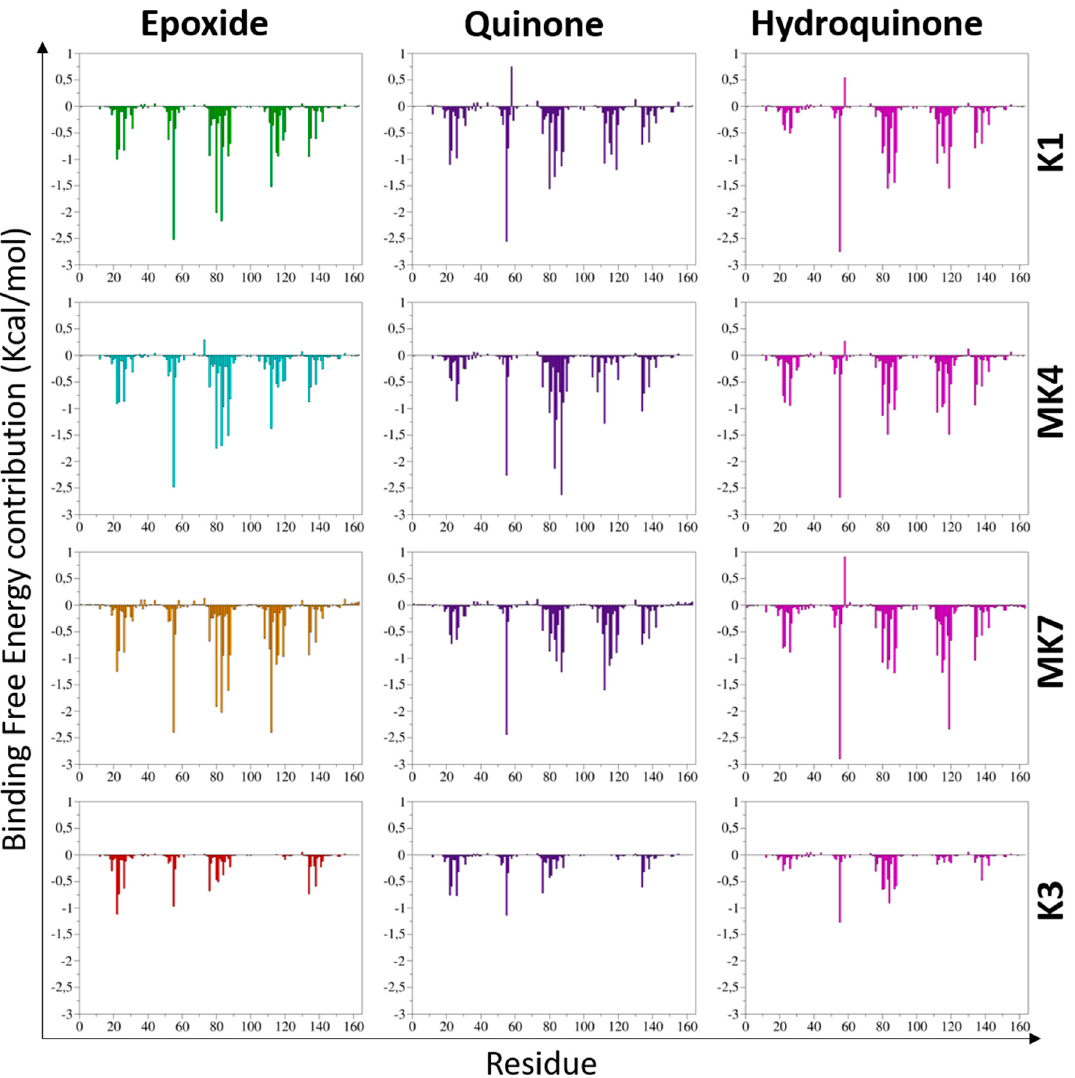
Figure 2. Contribution of vitamin K epoxide reductase (VKORC1) amino acids to the binding of vitamins K1, MK4, MK7, and K3 in their epoxide, quinone, and hydroquinone states. VKORC1 residue contributions to vitamins K binding are shown as green, cyan, orange, and red bars for the epoxide state of vitamins K1, MK4, MK7, and K3, respectively. VKORC1 residue contributions to vitamin K binding are presented as violet and pink bars for the quinone and hydroquinone states, respectively. Two 100-ns molecular dynamics (MD) simulations were performed on each vitamin K–VKORC1 complex, then concatenated to be considered as one 200-ns MD simulation.